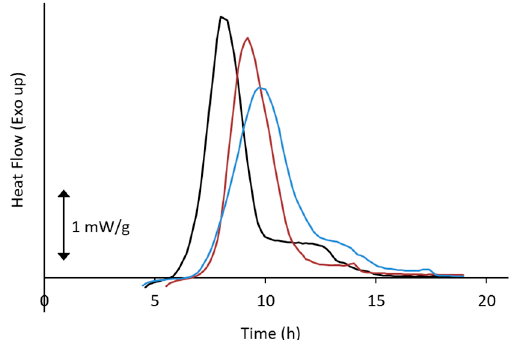
Figure 9. Effect of compression pressure on crystallization heat flow curves of sucrose glasses investigated by isothermal microcalorimetry (30 ◦ C). Freeze-dried sucrose was compressed at pressure of ca. 2.5 MPa (black), 0.5 MPa (red), or 0.1 MPa (blue) for 10 s and subjected to the measurement.